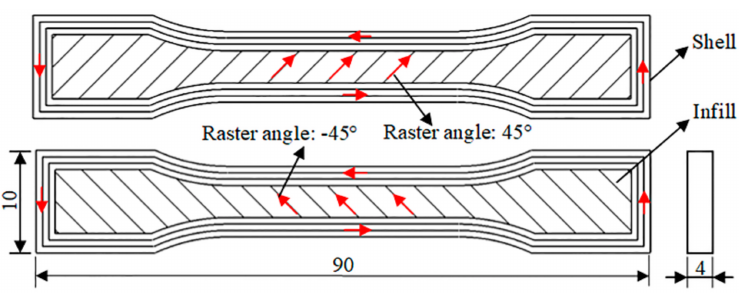
Figure 2. Samples for tensile tests and details of the processing